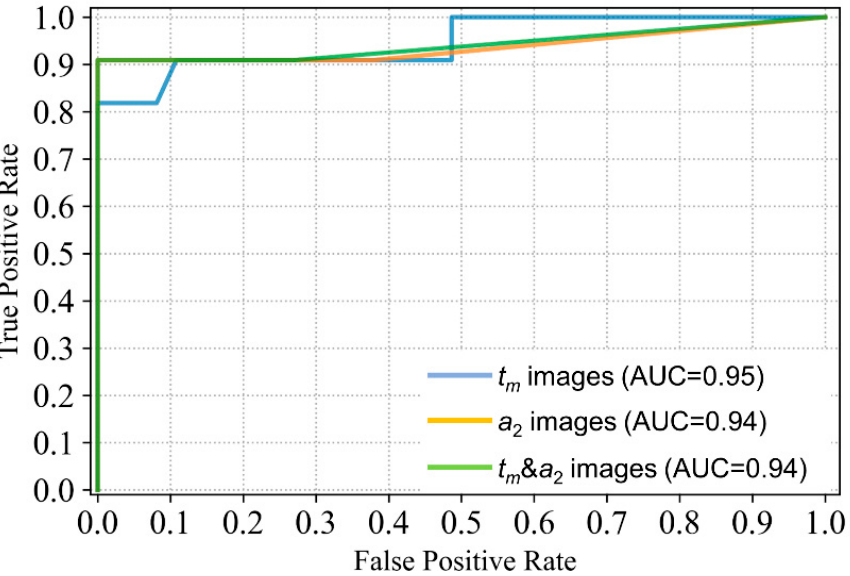
Figure 5. ROC curve and AUC for the three different input images. Clinical diagnosis based on colposcopy examinations, clinical laboratory tests, ultra- sound, and histopathology examinations was made by physicians and was considered the standard reference. According to the standard, the FPs and false negatives (FNs) of the FLIM-ML method and LBC test were evaluated and are marked in Table 3. For all patients with CC, CINII/III, VIN, and VaIN, the prediction of positive is true positive (TP). For all other participants, namely, benign, normal, and follow-up without detectable new lesions, the prediction of negative is true negative (TN). Confusion matrixes are presented in Figure 6 to visualize the performance of the LBC test and the FLIM-ML method for the validation dataset containing 48 participants. The LBC tests reported two FNs and five FPs. The FLIM-ML method reported one FN and no FPs. The sensitivity and specificity of the two methods were quantified and are listed in Table 4. The FLIM-ML method ex- hibits a good potential for reducing FPs, thereby potentially reducing unnecessary biopsies. Additionally, the FLIM-ML method showed a higher sensitivity than the LBC method in this